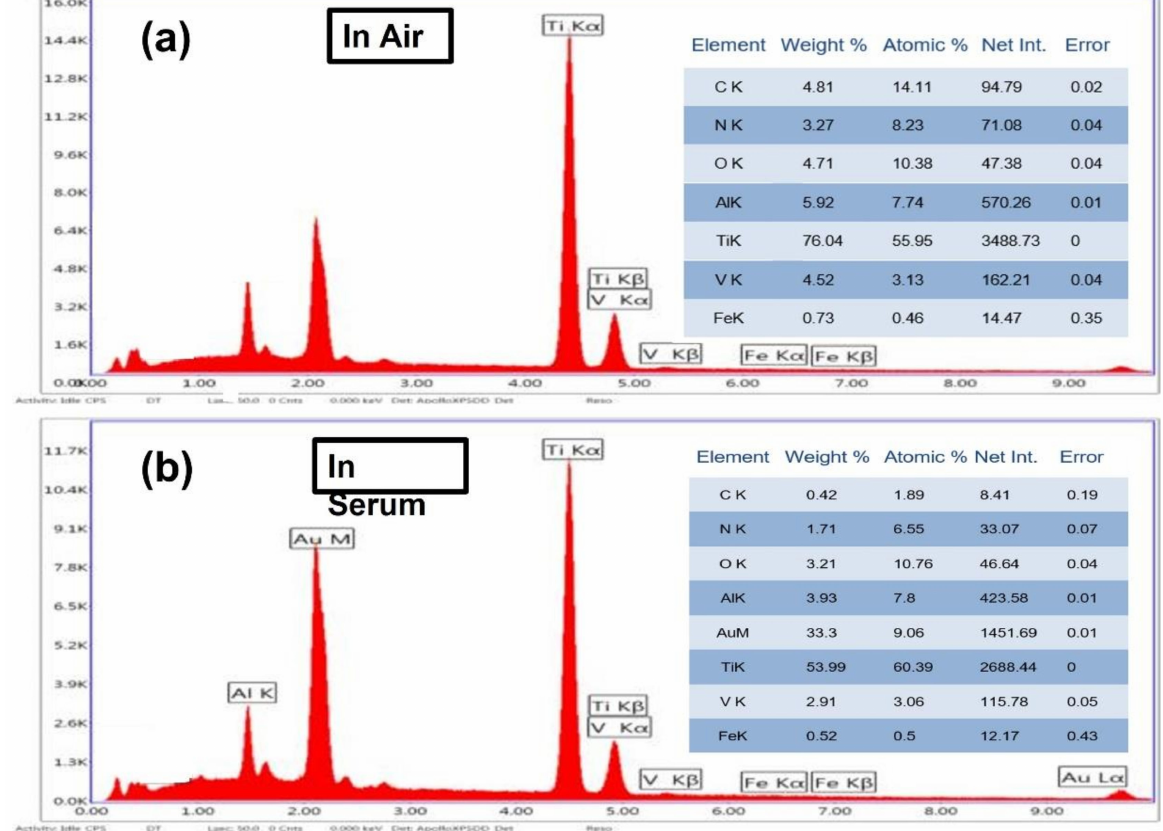
Figure 5. EDS spectra of Ti6Al4V welded in air ( a ) and in serum ( b ).